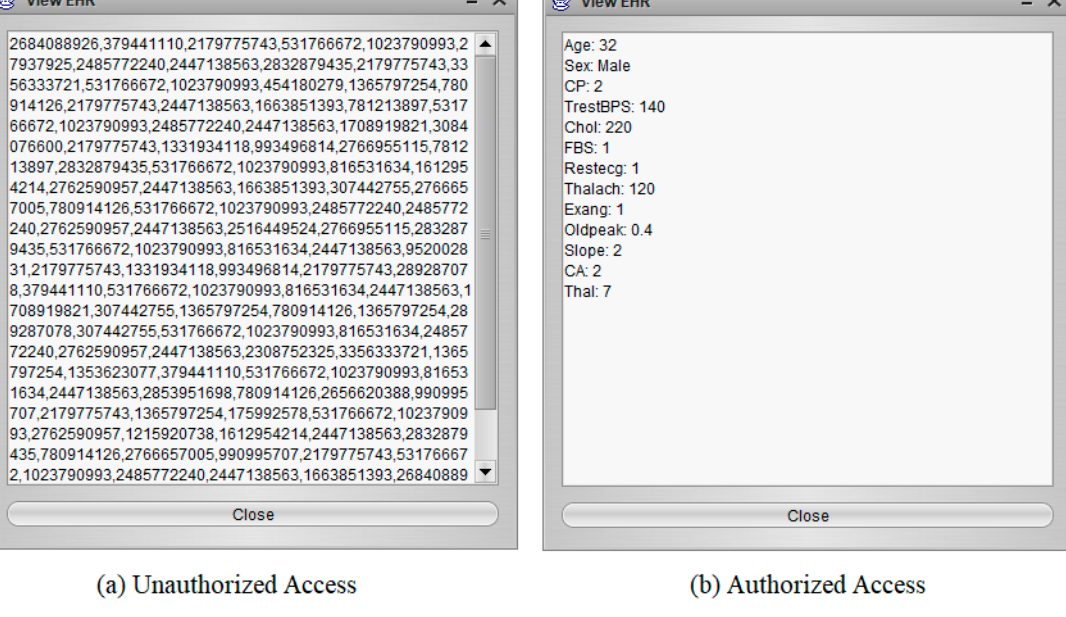
Figure 5. EHRs as a result of unauthorized access vs. authorized access.